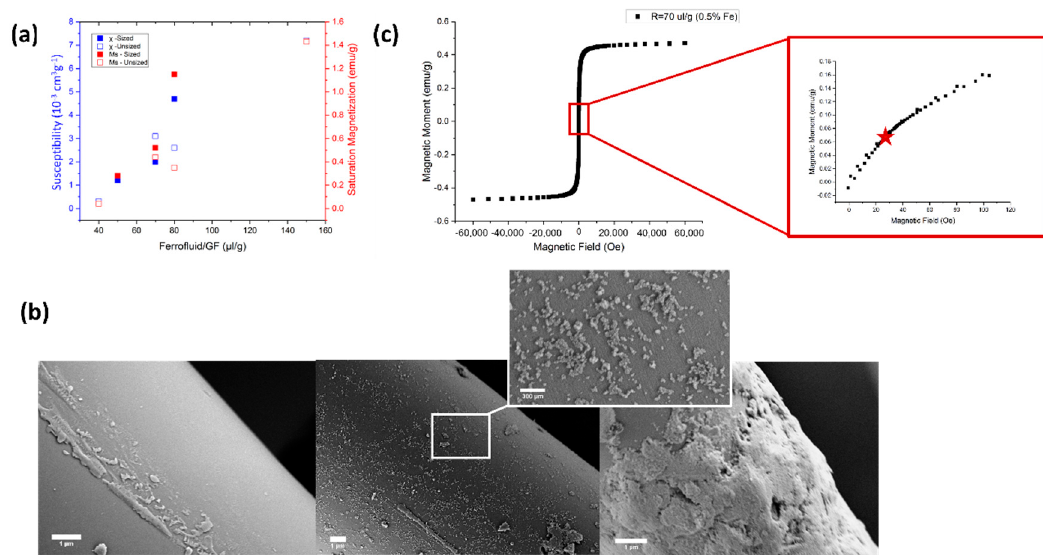
Figure 1. Magnetization of glass fibers. ( a ) The susceptibility (blue squares) and saturation magnetization (red squares) of magnetized glass fibers (MGF) measured by Superconducting Quantum Interference Device (SQUID) as a function of the ferrofluid concentration. Filled and hollow squares symbolize sized and unsized glass fibers, respectively. No effect of fiber interface on nanoparticles adsorption can be seen. ( b ) Electron microscopy images of fiber surface in the absence of magnetite coating (left), after mixing with 70 μ L/g of ferrofluid (middle), and after mixing with 150 μ L/g (right). In caption: zoomed-in image (scale bar = 300 nm) of the superparamagnetic iron oxide nanoparticles (SPIONs). ( c ) M–H curve for MGF treated with 70 μ L/g ferrofluid, corresponding to Fe content of 0.5%, showing paramagnetic behavior. In caption: zoom-in into the domain of low-fields, where the red star indicates the low magnetic field induced by the solenoid.